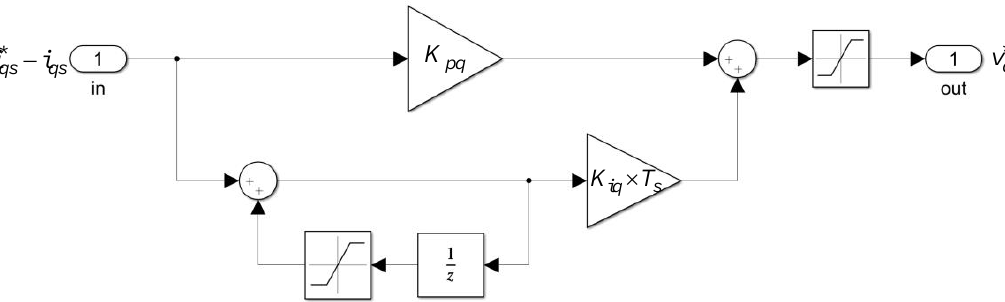
Figure 4. The structure of PI controller.